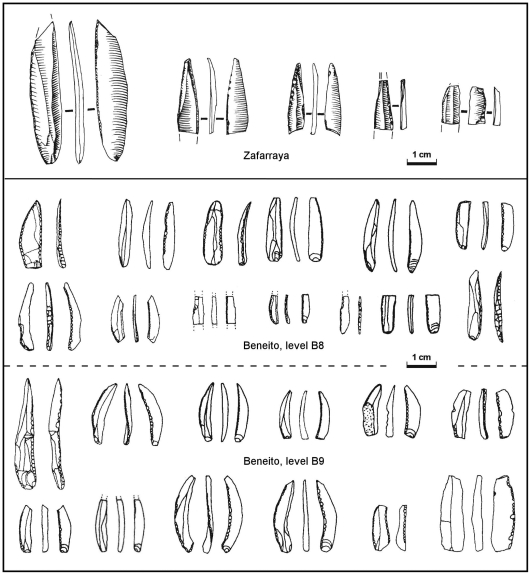
“Dufour bladelets”: in the Early Upper Paleolithic of southern Spain.With the exception of the longer piece from level B9, the material from Cova Beneito [86] fits the definition of the Roc-de-Combe subtype, while the Zafarraya pieces [87] are identical to those from Pego do Diabo.